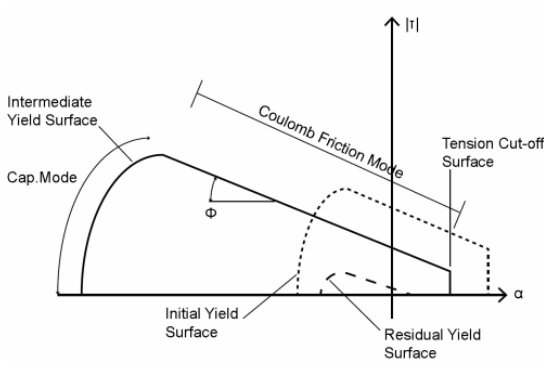
Figure 14. Interface model (adapted from Ref. [308]).